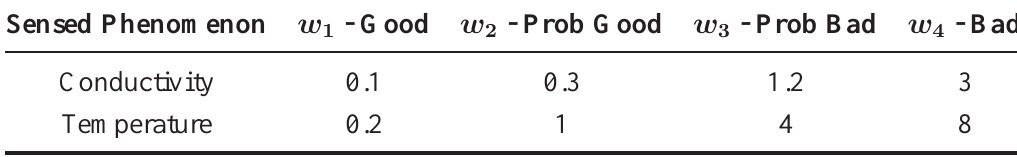
Table 2. The weights used to generate error bars for each assessed data sample based upon the posteriors of the quality states. The weight w corresponds to the sensor accuracies 1 specified by the manufacturer whilst the other values were based upon the empirical values in [14] but modified to incorporate 4 classes as opposed to 3